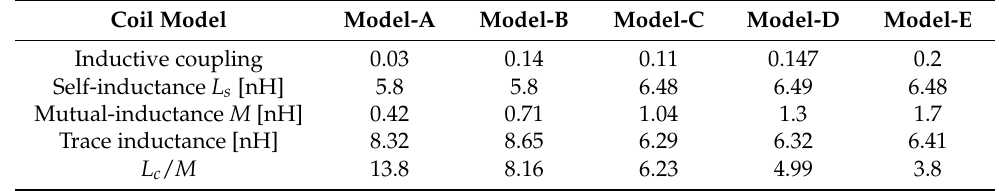
Table 1. Comparison of the dependent coil structures using finite element method with the FEA